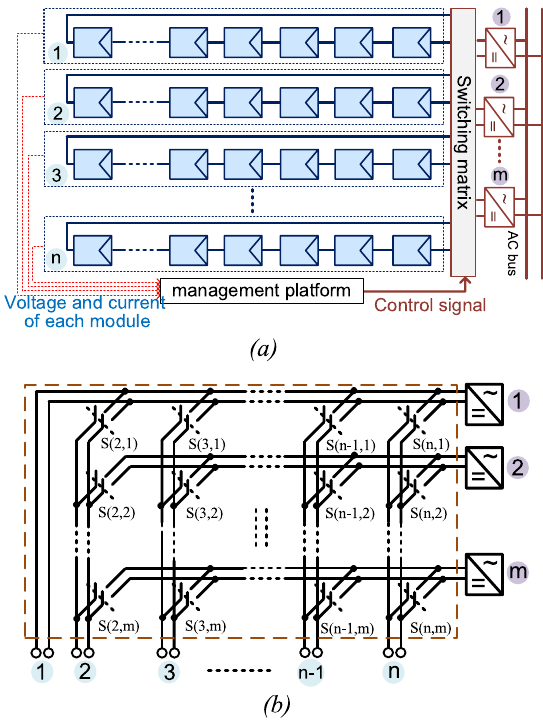
Fig. 5 The proposed method for the SP-based PV array ( a ) Interconnection configuration; and ( b ) designed switching